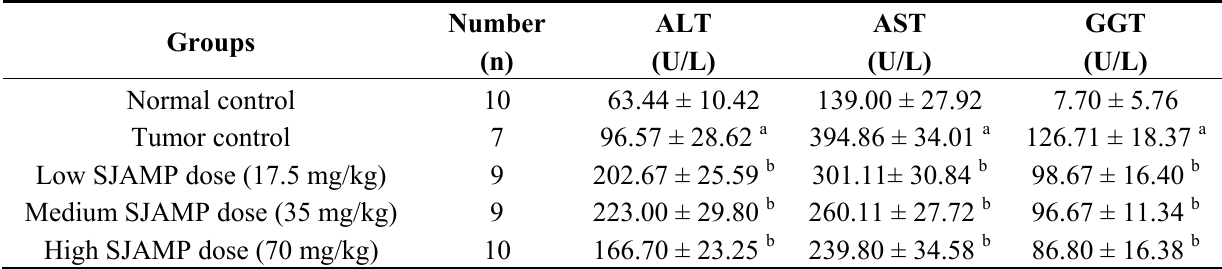
Table 3. Effect of SJAMP on the levels of serum ALT, AST and GGT in rats with DEN-induced HCC ( x ±